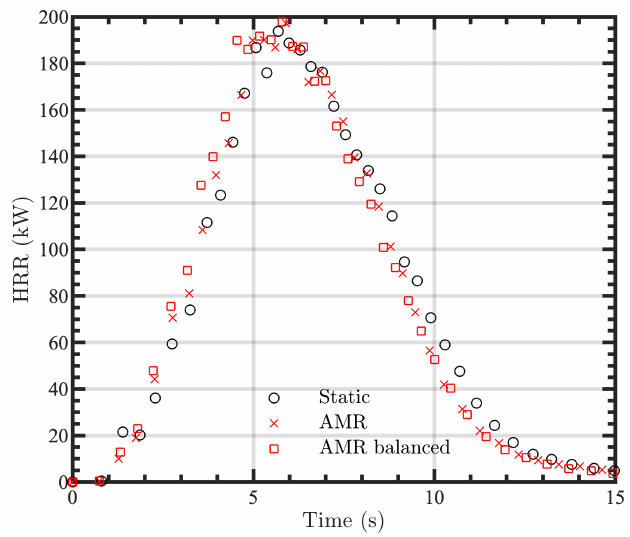
Figure 3. Comparison of chemical HRR time histories for the single panel vertical fire spread verification test case in the static (black circles), AMR without load balancing (red crosses), and AMR with load balancing (red squares) simulations. HRR is computed from instantaneous mass loss rates from the solid.